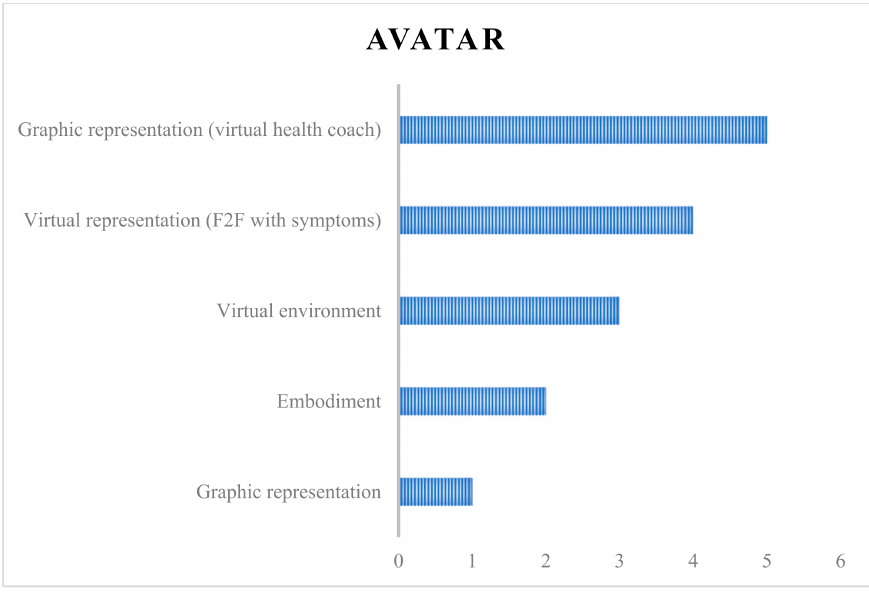
Figure 2. Categorization of avatars.